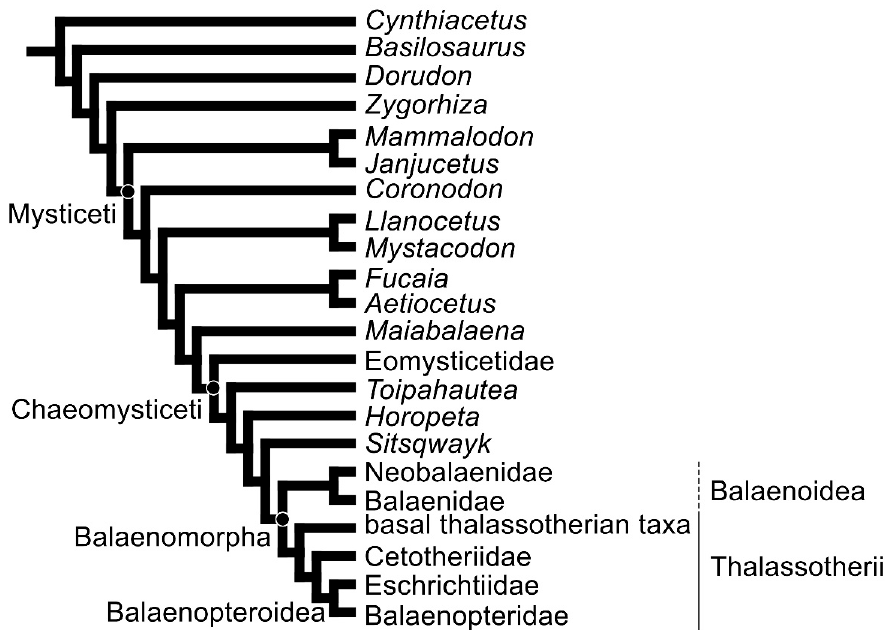
Figure 5. Phylogenetic relationships among the main mysticete clades used in this paper. The three named, high-rank clades Mysticeti, Chaeomysticeti and Balaenomorpha are circled. Relationships among superfamilies (Balaenoidea and Thalassotherii), one epifamily (Balaenopteroidea) and families are shown.